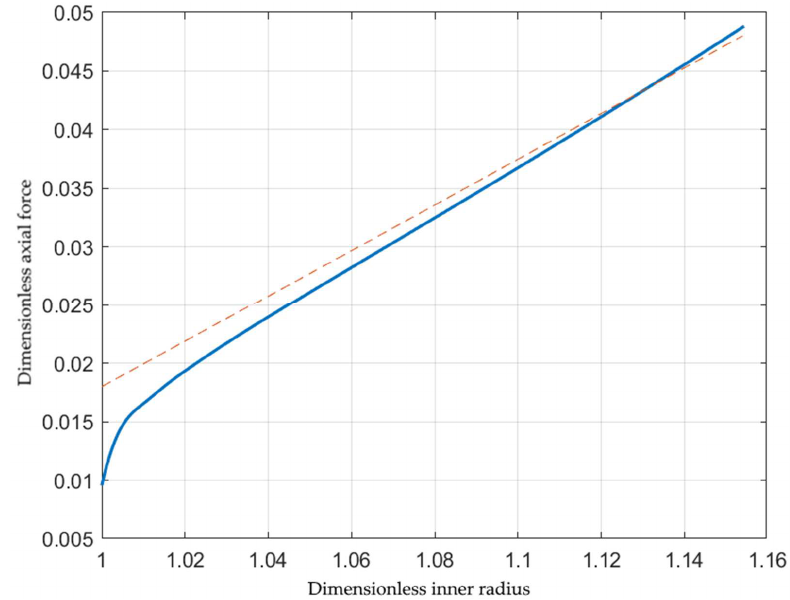
Figure 6. Comparison of the theoretical prediction of the axial force and experiment [24]. The solid line corresponds to the theoretical prediction and the broken line to the experiment.